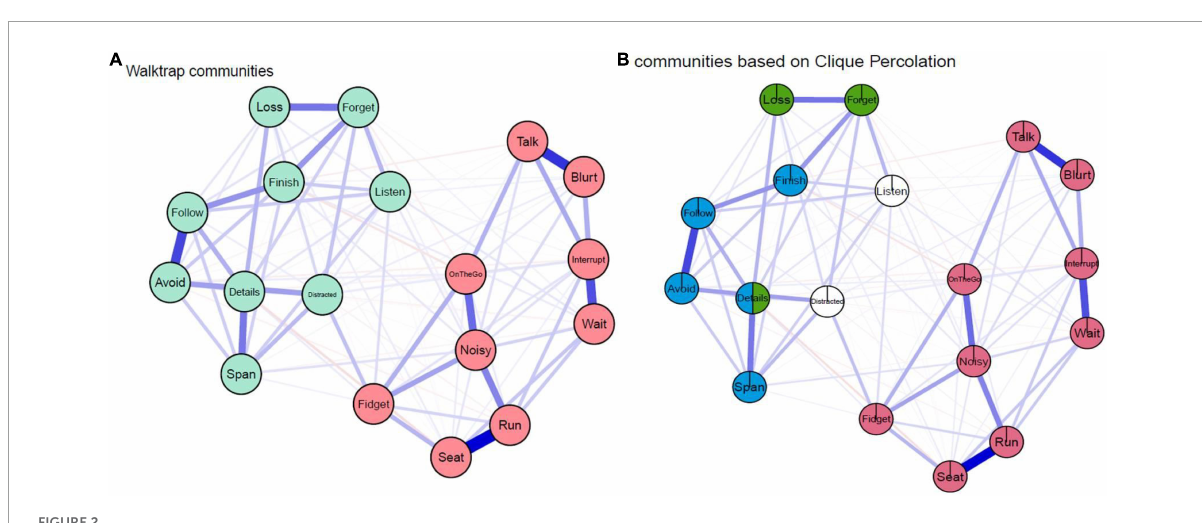
FIGURE2 Communities detected by (A) Walktrap algorithm: The R packages “EGAnet” was used to detect communities in the network and two communities were identified. (B) Clique Percolation algorithm: K was set as three as the algorithm requires a minimum k of 3 and I was set as 0.15 to obtain the highest ratio threshold and a large χ threshold. The R package “Clique Percolation” was